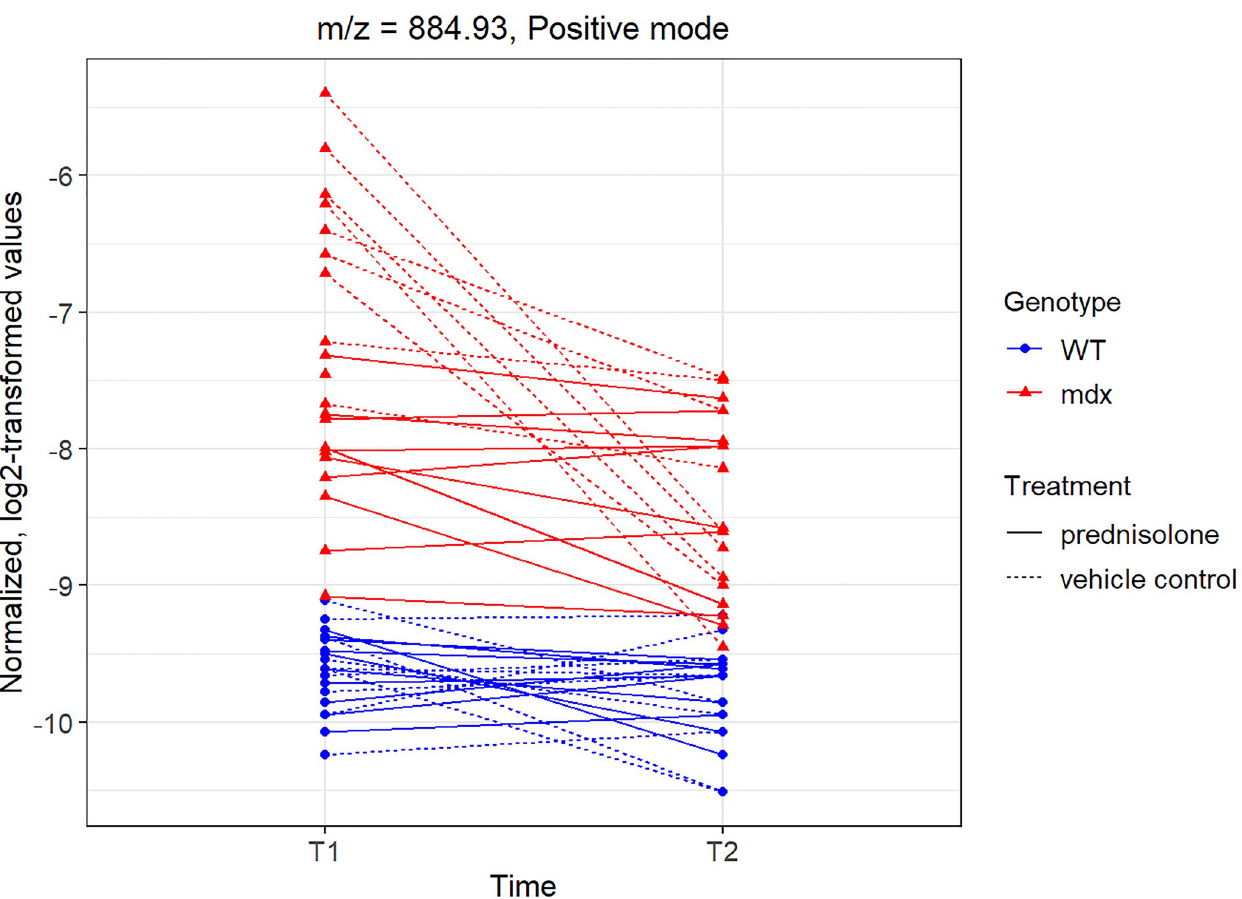
Fig 7. Normalized, log2-transformed intensity values at times T1-T2 for peak with m/z = 884.92 in positive